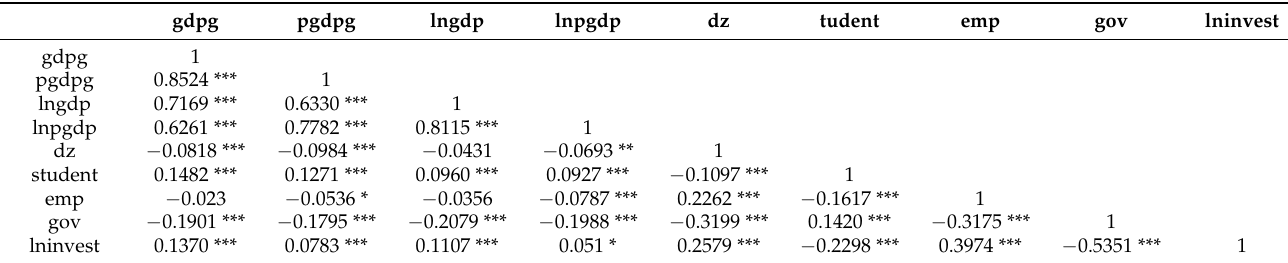
Table 3. Correlation matrix of the